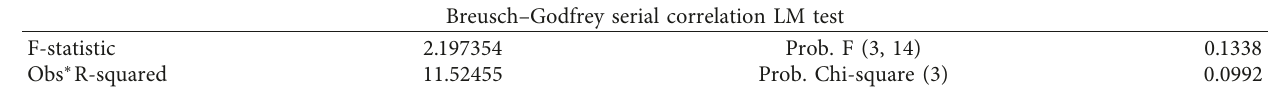
Table 8: Results of the serial correlation test.